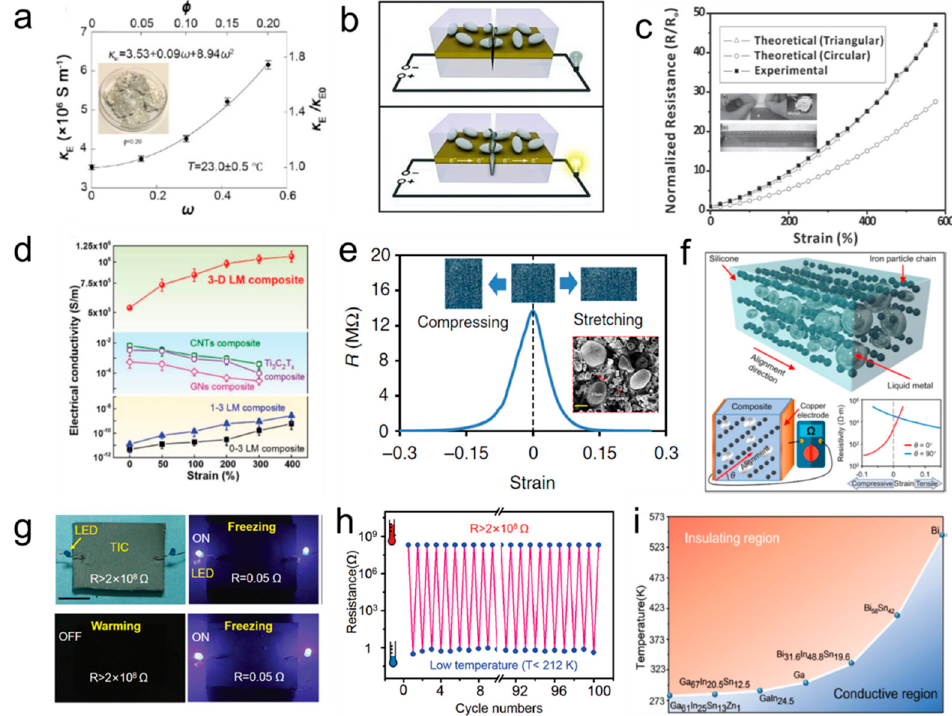
Figure 3. Electrical properties of liquid metal and its composite. ( a ) The enhanced electrical conductivity of liquid metal (LM) by mixing Cu particles [47]. Copyright (2017) American Chemical Society. ( b ) The process of autonomic conductivity restoration of a circuit containing liquid metal particles [49]. Copyright (2012) WILEY-VCH. ( c ) The relationship between resistance and strain [53]. Copyright (2013) WILEY-VCH. ( d ) Electrical conductivity as a function of the strain of the composites [55]. Copyright (2020) WILEY-VCH. ( e ) The resistance-strain curve of the liquid metal-filled magnetorheological elastomer. Stretching and compression all enhance conductivity [56]. Copyright 2019, Springer Nature. ( f ) The liquid metal composites enhanced electrical anisotropy under deformation [57]. Copyright (2020) American Chemical Society. ( g ) The liquid metal-based composite becomes conductive after freezing and recovers to electrical insulative again after warming. ( h ) Resistance change between electrical insulative and conductive for 100 cycles under the temperature regulation [59]. Copyright (2019) WILEY-VCH. ( i ) The conductive and insulating regions based on the melting points of the liquid metal droplets dispersed in dimethicone [61]. Copyright (2019) American Chemical Society.